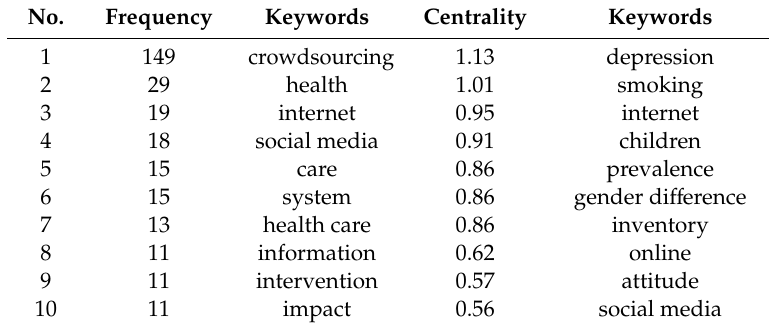
Table 5. Summary of top 10 keywords on the crowdsourcing applications for public